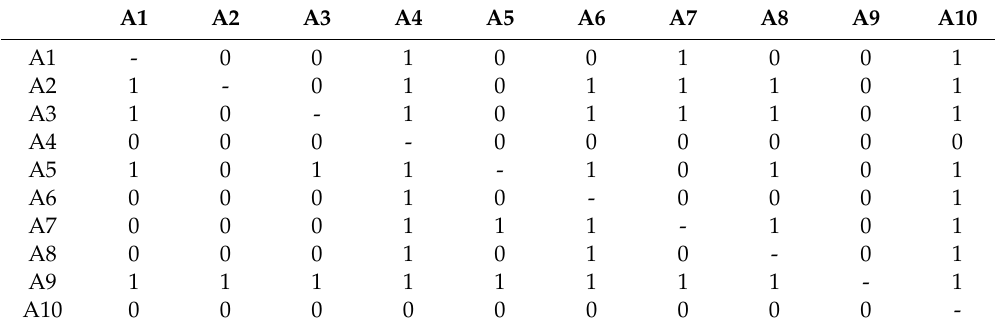
Table 25. Boolean matrix H based on the minimum discordance level.